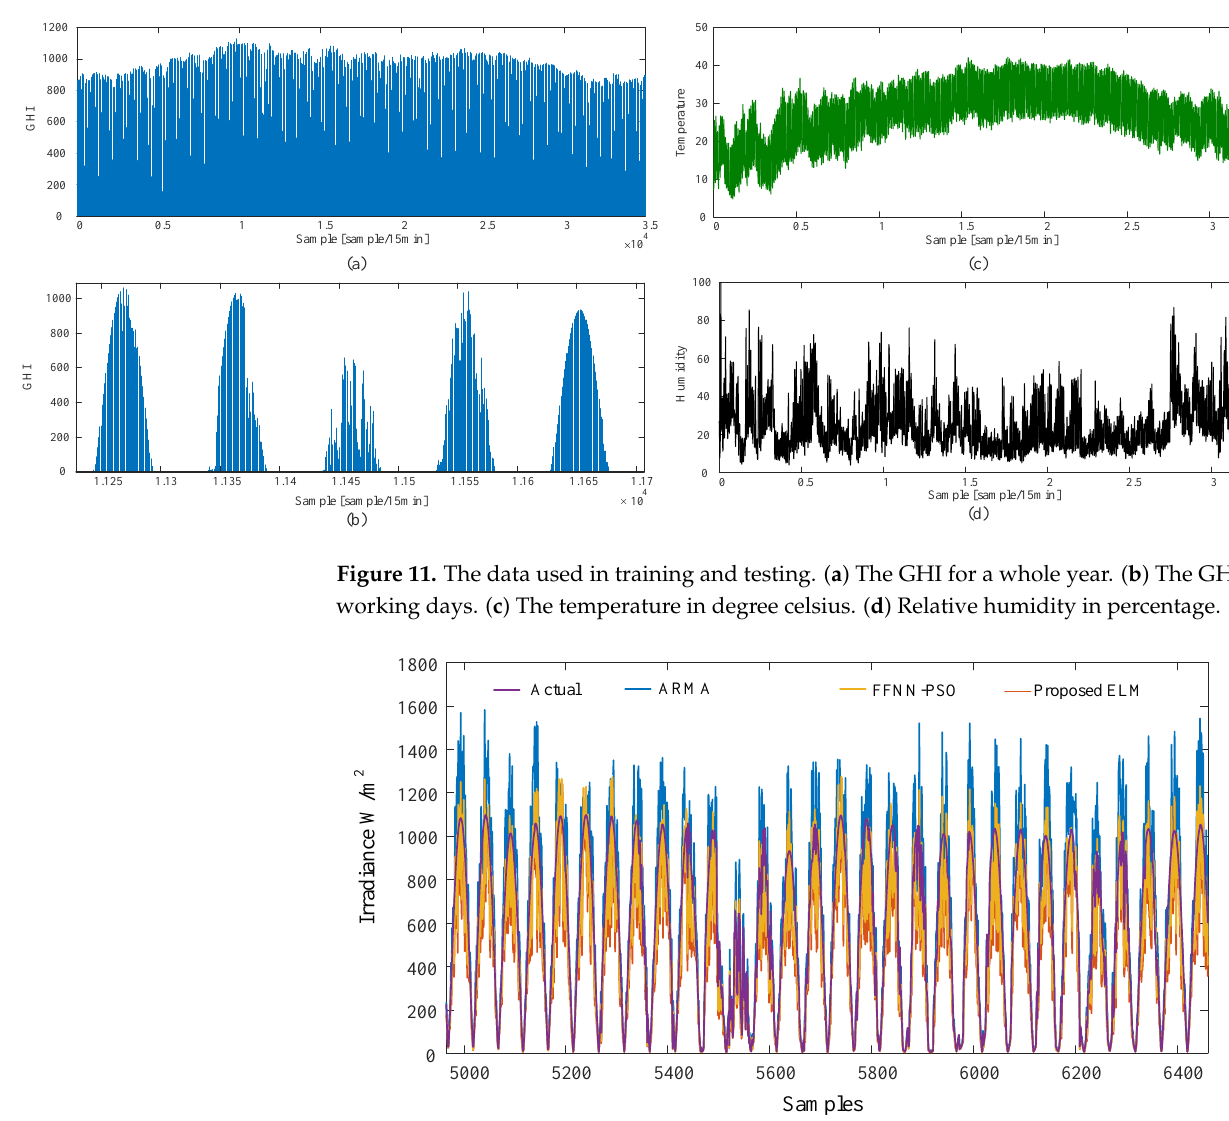
Figure 12. The predicted samples of the ARMA, FNN-PSO, and the proposed method compared to the actual values of